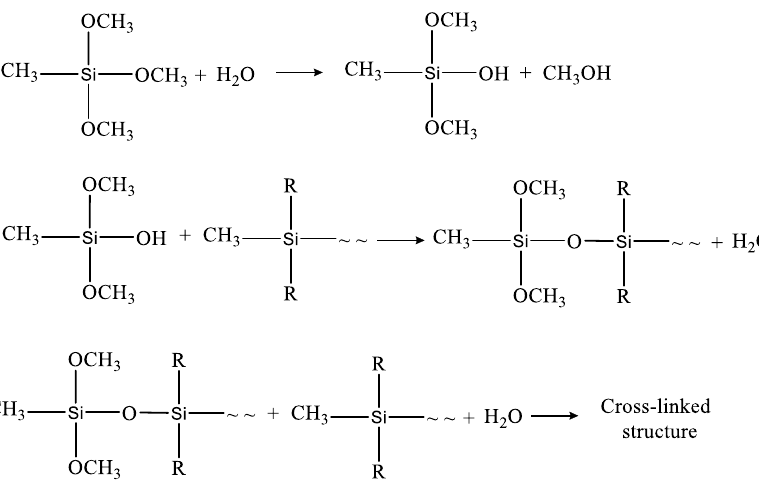
Figure 2. Chemical reaction in room temperature vulcanization (RTV) [16].